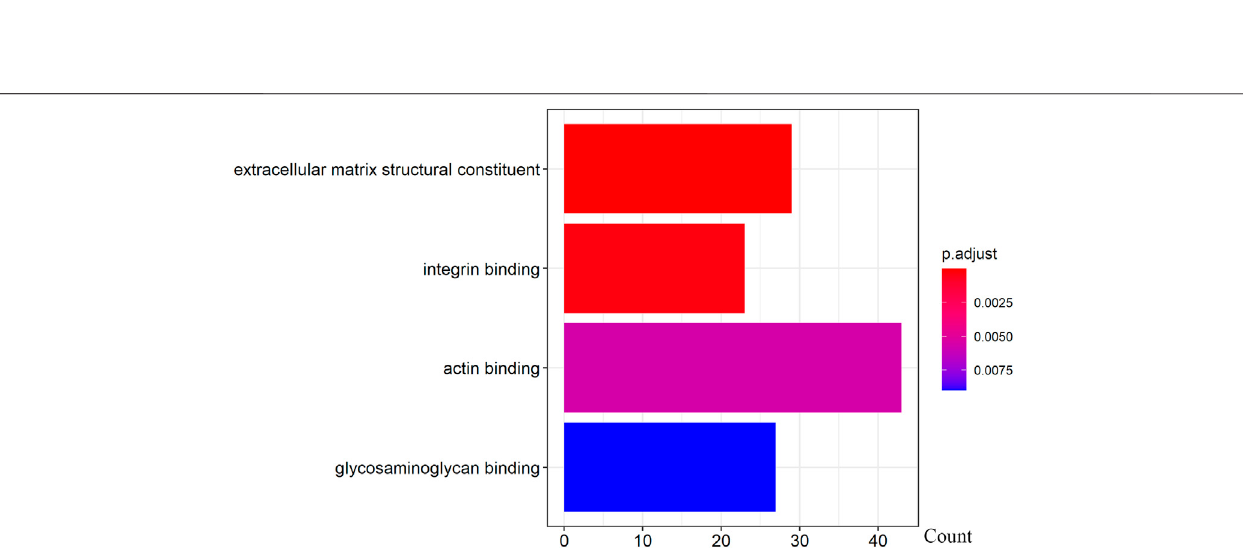
Frontiers in Genetics |